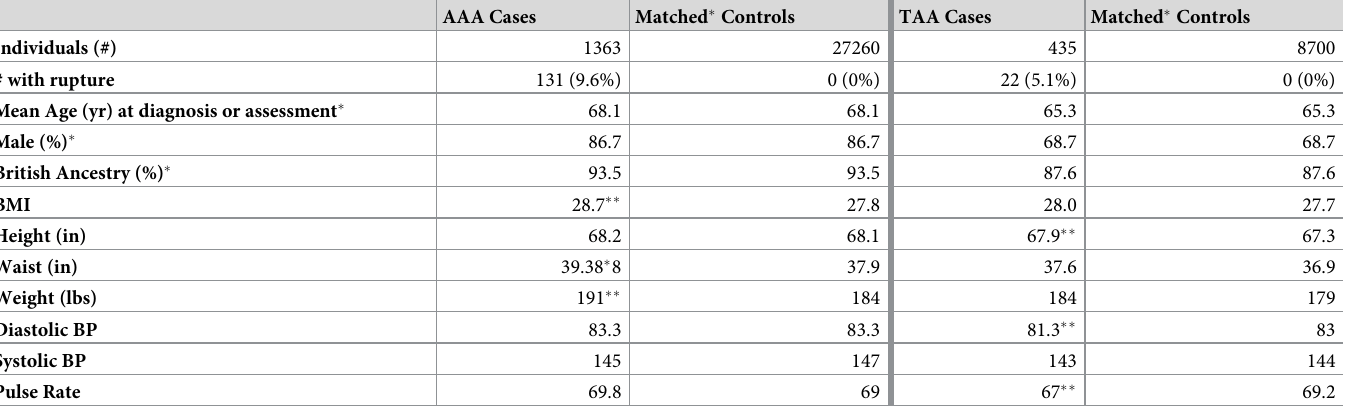
Table 1. Basic demographics and characteristics of individuals with abdominal aortic aneurysm (AAA) and thoracic aortic aneurysm (TAA), and the respective matched (for age, sex, ancestry) controls in UK Biobank. AAA Cases Matched � Controls TAA